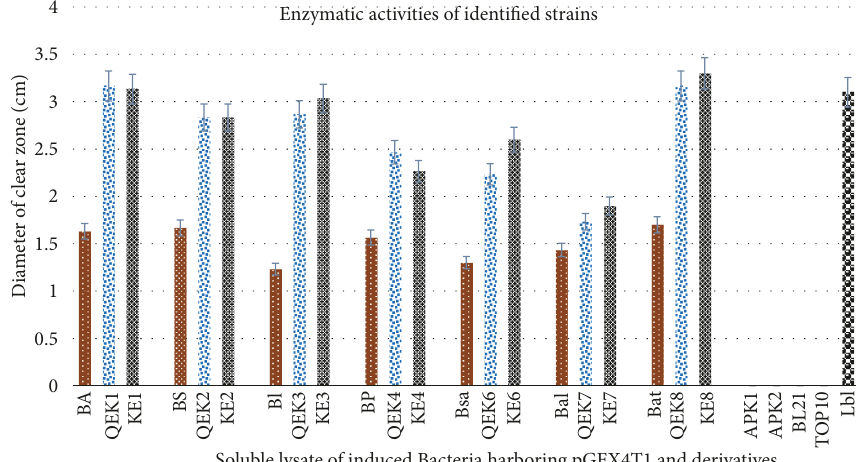
Figure 3: Enzymatic activities of identified strains belonging to group I of Bacillus spp. BS: B. subtilis , Ba: B. amyloliquefaciens , Bl: B. licheniformis , Bp: B. pumilus , Bal: B. altitudinis , Bsa: B. safensis , Bat: B. atrophaeus . KE1 (pGEX-4T-1: fibEma-Ba /TOP10), KE2 (pGEX- 4T-1: fibEma-Bs/TOP10), KE3 (pGEX-4T-1: fibEma-Bl/TOP10), KE4 (pGEX-4T-1: fibEma-Bp), KE6 (pGEX-4T-1: fibEma-Bsa/TOP10), KE7